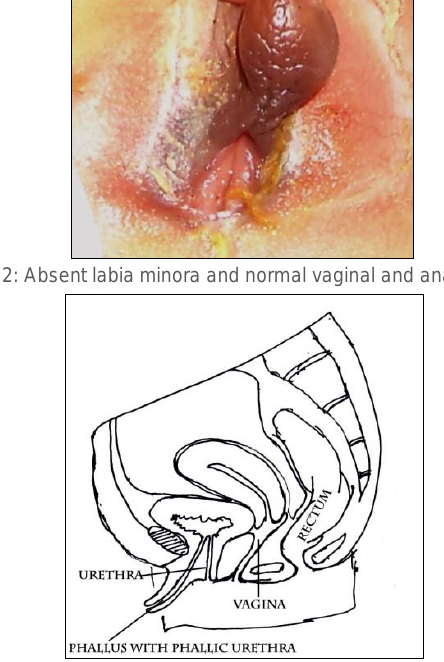
Figure 3 – Schematic diagram showing phallus with accessory phallic